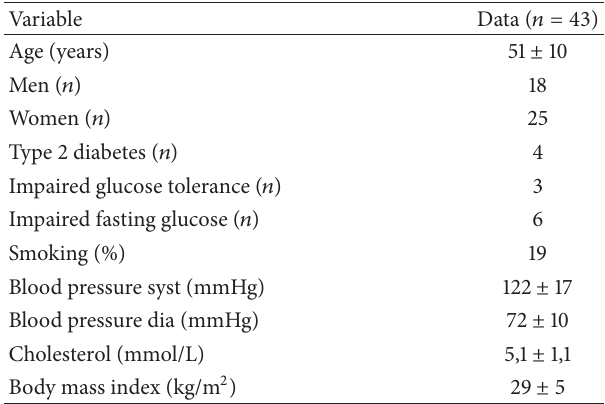
Table 2: Anthropometric characteristics of the surveyed population and outcome regarding glucose